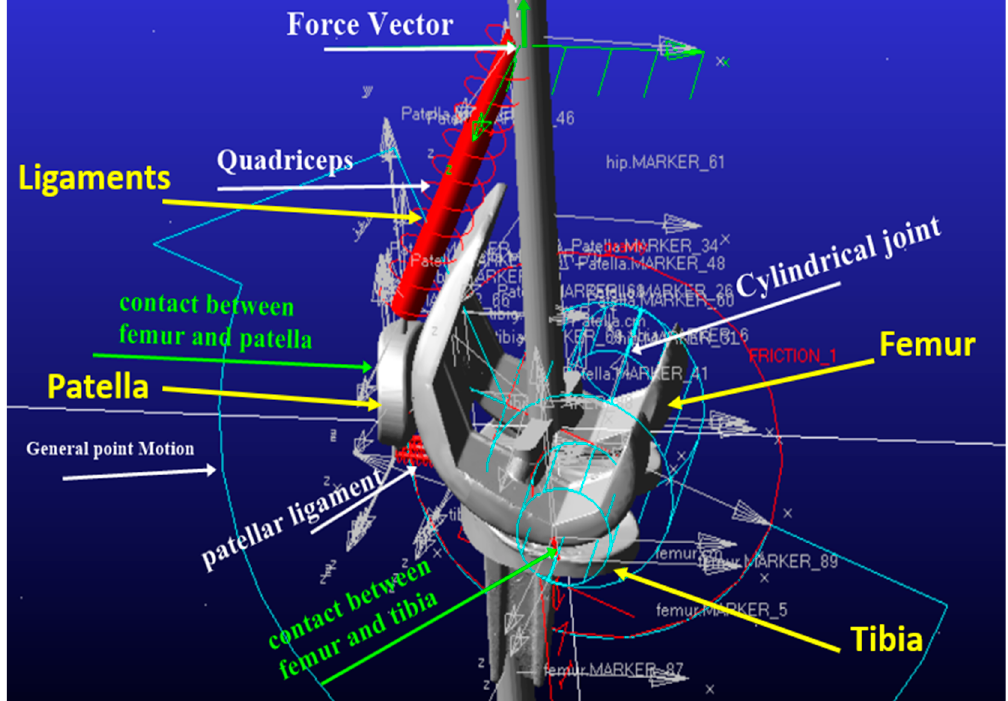
Figure 8. Our Multibody model in the MSC.ADAMS.